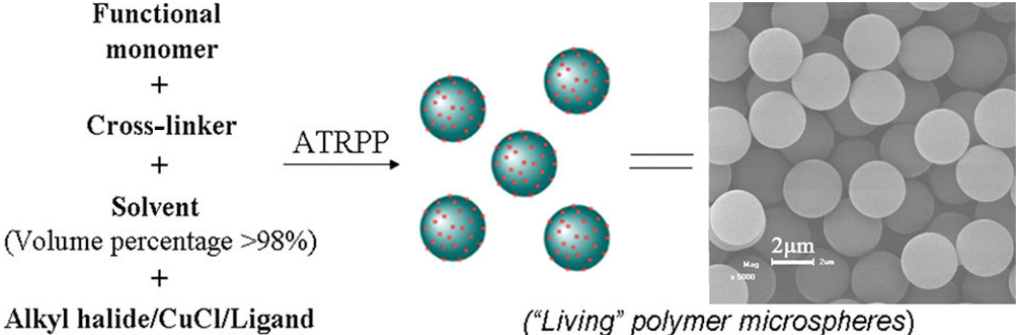
Figure 6. The synthetic scheme of the uniformly crosslinked “living” polymer microspheres. Reprinted with permission from Ref. [98]. Copyright 2011 American Chemical Society.